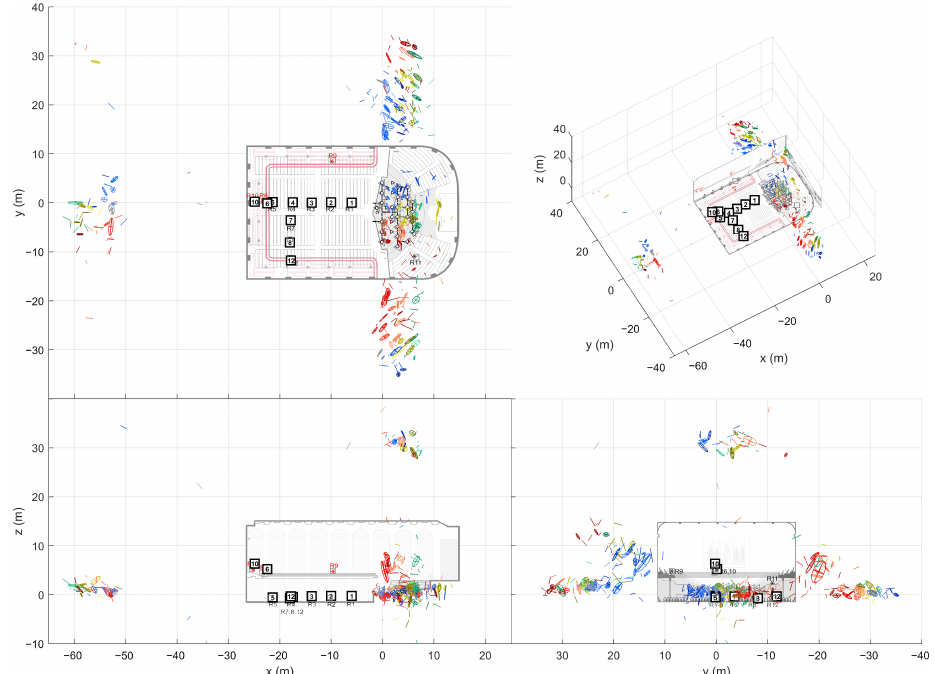
Figure A7. Found image sources for loudspeaker orchestra in Amsterdam Concertgebouw (min. 2 ER objects per image